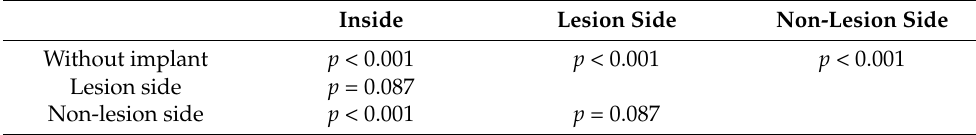
Figure 6. Summarized evaluation of each scenario investigated with